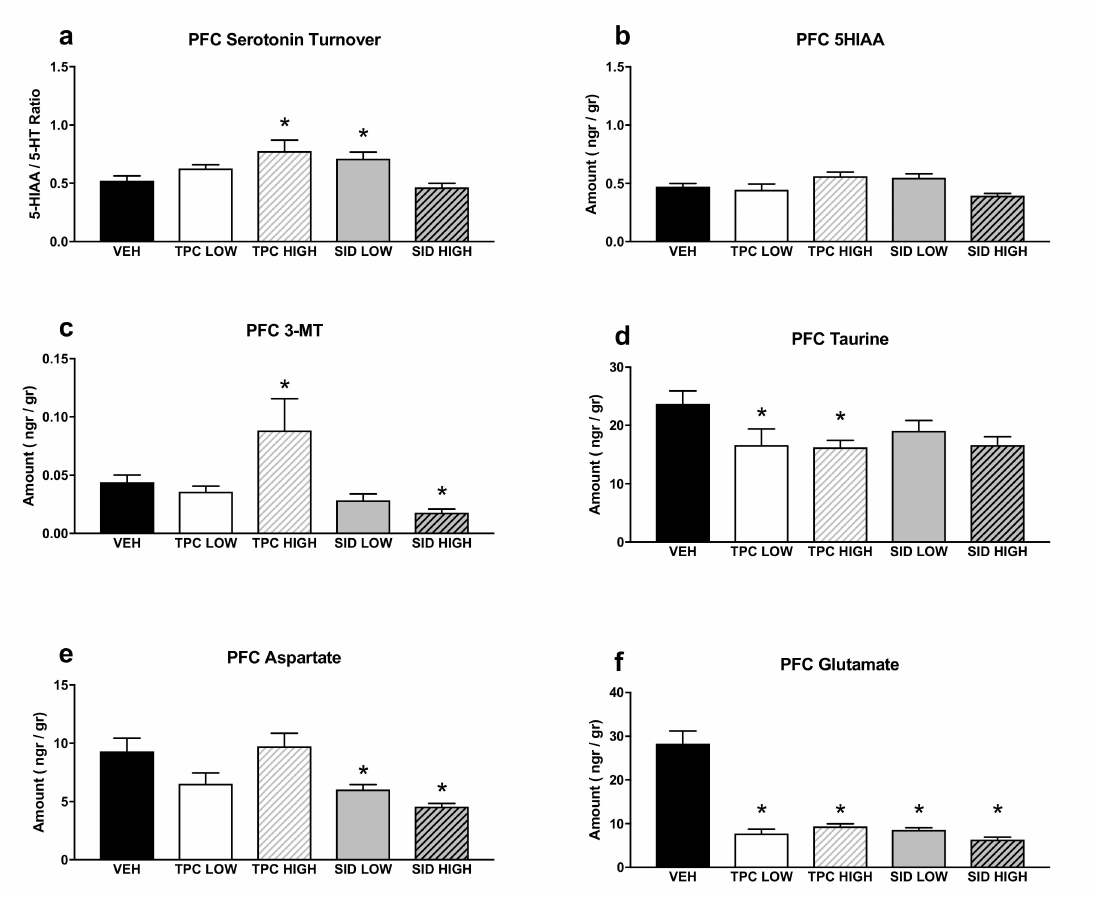
Figure 5. Aminoacids and monoamines in the prefrontal cortex (PFC). ( a ) Serotonin turnover rate, calculated as the 5-HIAA / 5-HT ratio; ( b ) 5-HIAA tissue levels; ( c ) 3-MT tissue levels; ( d ) taurine tissue levels; ( e ) aspartate tissue levels; ( f ) glutamate tissue levels. TPC Low Dose = 10 mg / kg, High Dose = 30 mg / kg, SID Low Dose = 50 mg / kg, High Dose = 150 mg / kg. N = 7–9 / group. An asterisk denotes a significant di ff erence between a treatment group and the corresponding vehicle-treated control